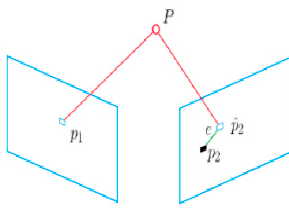
Figure 3. The re-projection error.